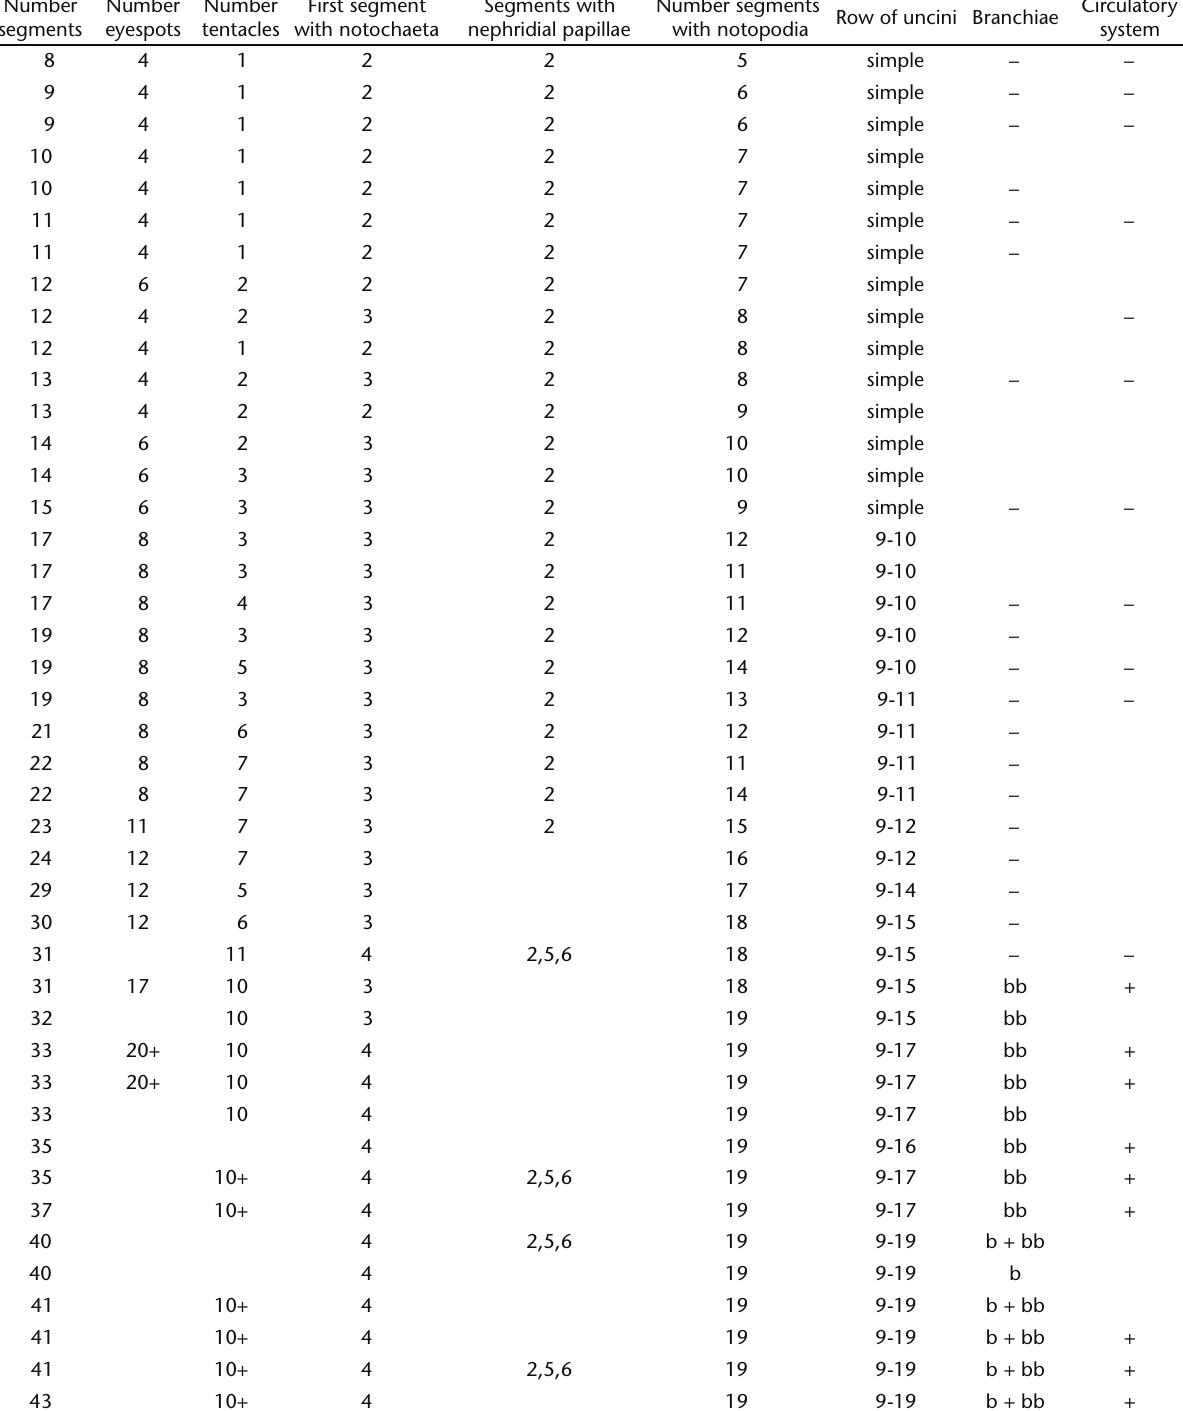
Table I. Nicolea uspiana : morphological features in individuals of different sizes. (+) Present, (–) absent or no information, (bb) branchial bulb, (b) branchia. Number Number Number segments eyespots